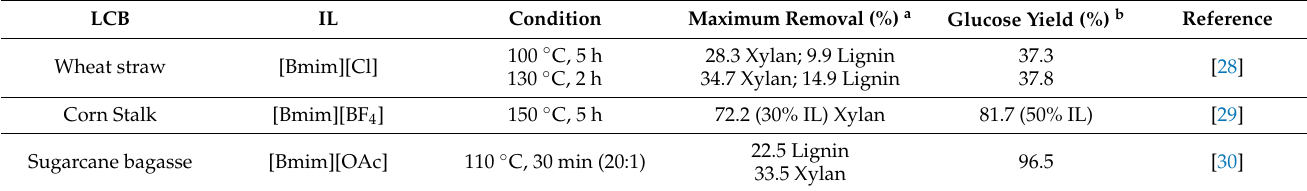
Table 1. Summary of the literature on LCB dissolution for biofuel